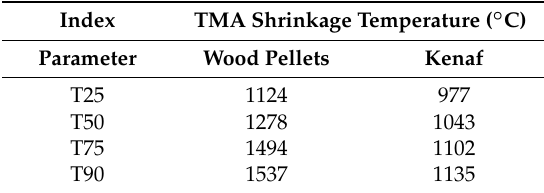
Table 2. TMA shrinkage parameters for the biomass ash